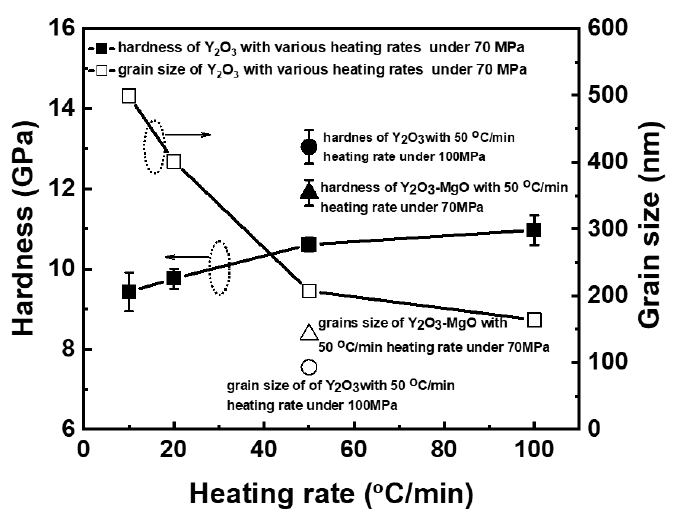
Figure 10. Heating rate dependent Vickers hardness Hv and grain size of the Y 2 O 3 ceramics. For comparison, Hv and grain size of the Y 2 O 3 -MgO nanocomposite sintered at 1250 °C under 70 MPa (triangles) [34] and Y 2 O 3 ceramic fabricated at 1130 °C under 100 MPa (circles) are also given, respectively.